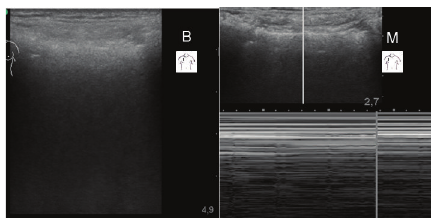
Figure 1: Case 1 : B-mode and M-mode sonography using a linear transducer positioned in the mid-clavicular line at the 3rd left intercostal space. Arrows indicate the pleural lines (B: B-mode, M: M-mode).